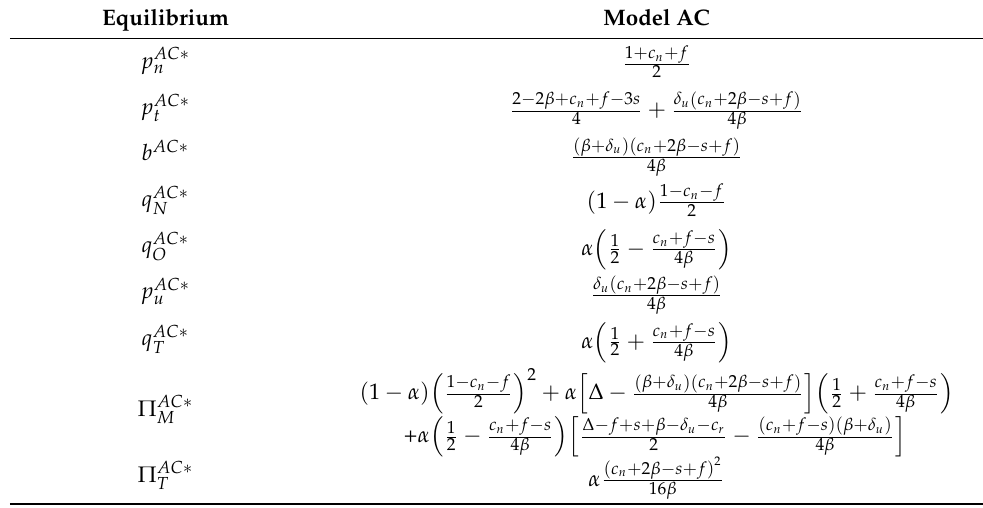
Table 9. Optimal solution of Model AC closed-loop supply